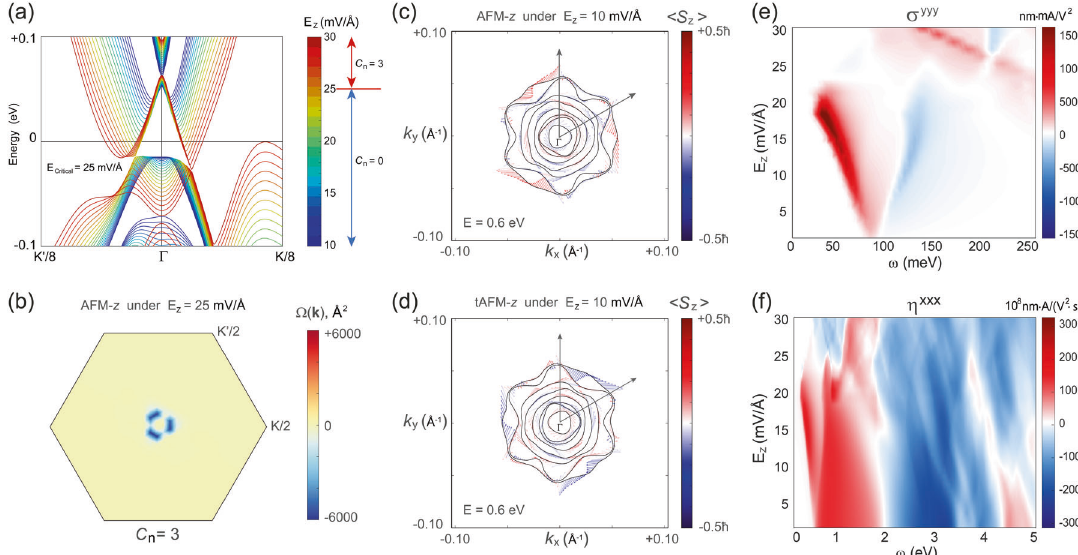
Fig. 4 Electric fi eld-dependent electric structure, topology, and photocurrent responses in bilayer AFM- z MnBi 2 Te 4 . a Electric fi eld- dependent band structure. b Berry curvature at the critical vertical electric fi eld of E z ¼ 25mV Å − 1 where it undergoes topological phase transition from zero-plateau quantum anomalous Hall insulator with Chern number C n ¼ 0 to high Chern number quantum anomalous Hall insulator ( C n ¼ 3 ). c , d Spin polarization of bilayer MnBi 2 Te 4 at energy of 0.6 eV with AFM- z and tAFM- z magnetic ordering under a vertical electric fi eld of E z ¼ 10mV Å − 1 which enables large spin splitting. e Normal shift photocurrent (NSC) susceptibility, σ yyy MnBi 2 Te 4 under varying external static vertical electric fi eld E z and fundamental frequency ω . f Magnetic injection current (MIC) susceptibility, η xxx , in bilayer AFM- z MnBi 2 Te 4 under varying external static vertical electric fi eld E z and fundamental frequency ω MIC